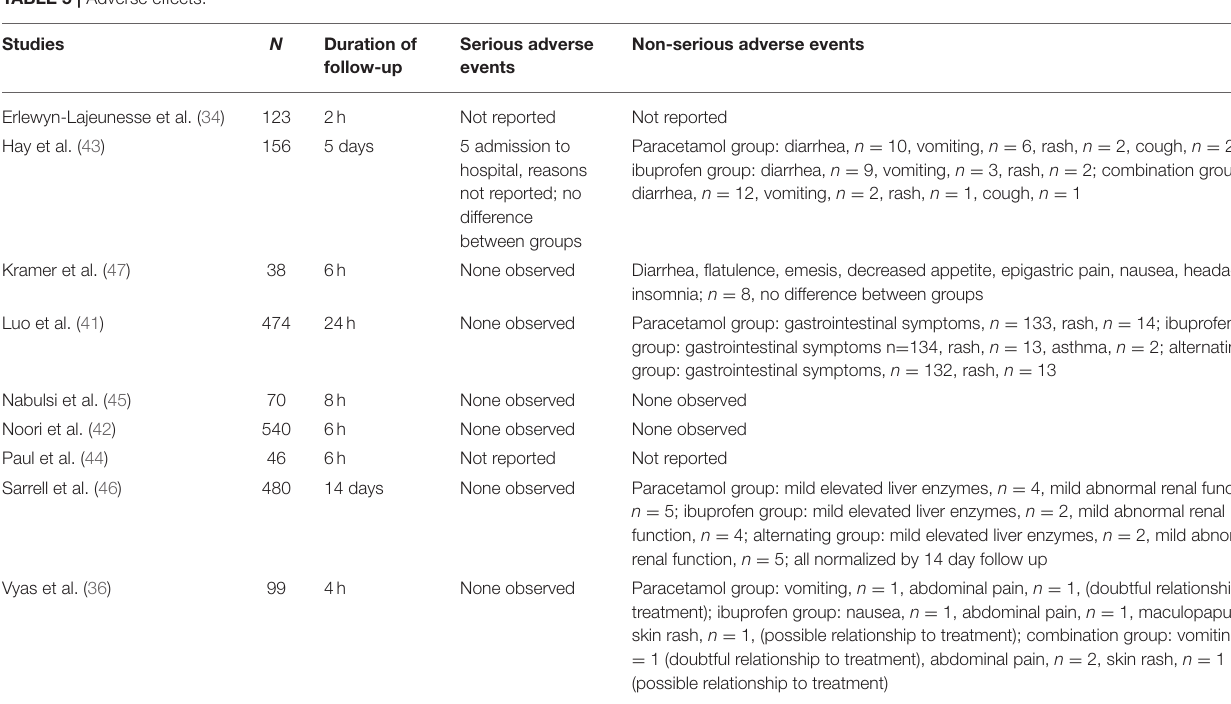
TABLE 5 | Adverse